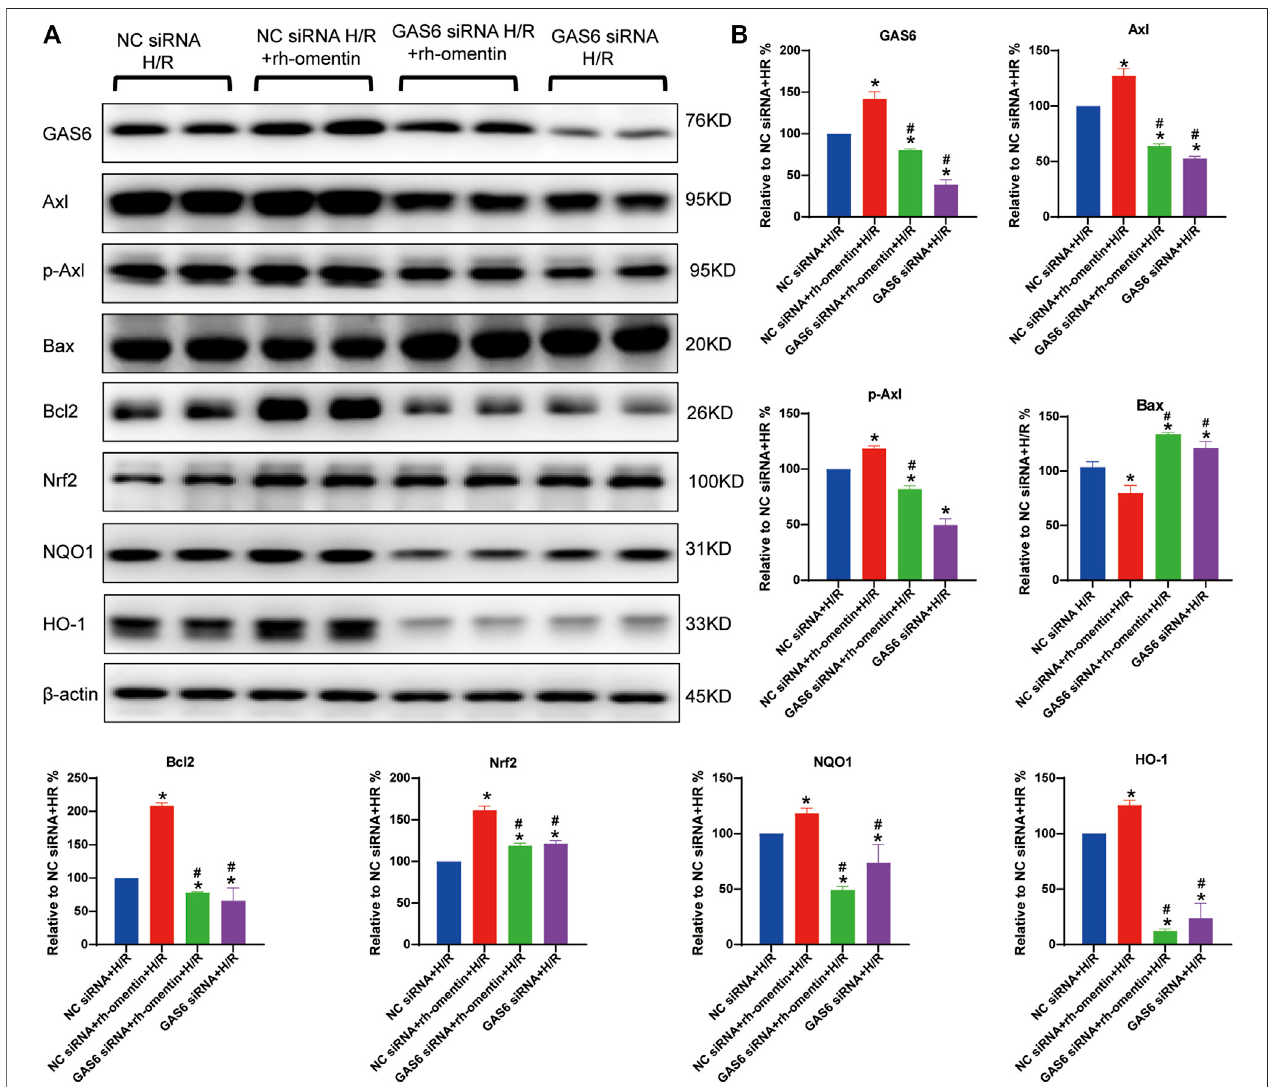
FIGURE 7 | Effect of GAS6 siRNA and rh-omentin on GAS6/Axl signaling in N2a cells injured by H/R. (A) The representative images of GAS6, Axl, p-Axl, NQO1, HO-1,Nrf2, Bax, and Bcl2 detectedby Western blot. (B) Quantitative analysisofWesternblot bynormalizingto β -actin. Errorbars show thestandard deviation for n (cid:2) 6 measurements from representative experiments. * p < 0.05 vs . the Control siRNA + H/R; # p < 0.05 vs. the NC siRNA + rh-omentin + H/R group.